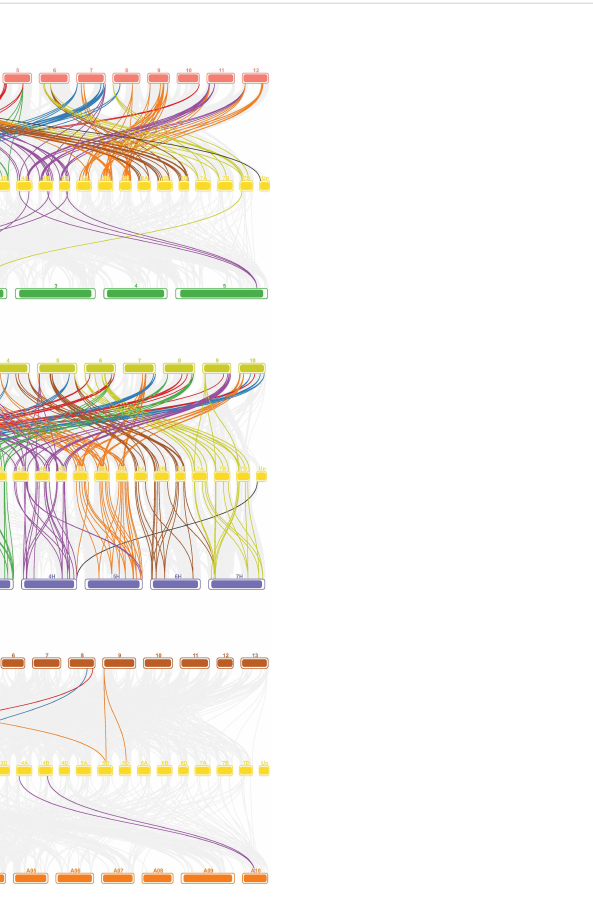
FIGURE 4 Synteny analysis of PHD genes in wheat. All TaPHD genes were mapped to their respective locus in the wheat genome in a circular diagram using shinyCircos (Yu et al., 2018). Subgenomes are indicated by different shades of blue (outer track), and chromosomal segments are indicated by shades of gray (inner track). Homoeologous PHD genes were inferred by phylogeny (for details see the Materials and Methods section) and linked with chromosome-speci fi c